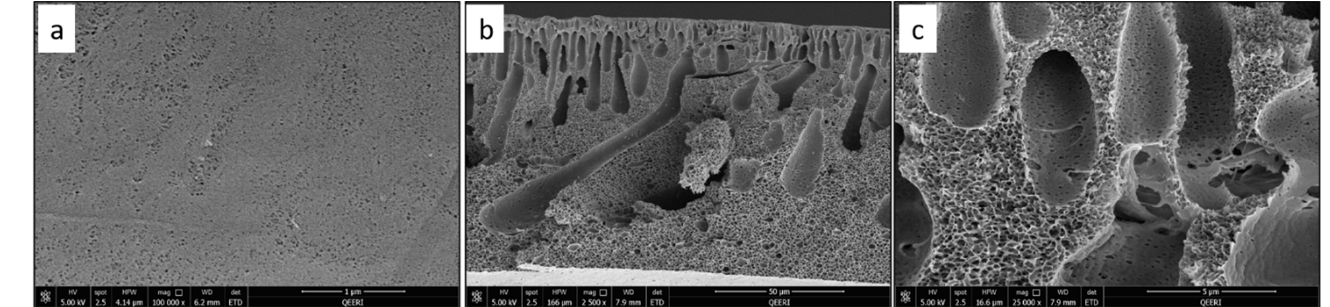
Figure 8. SEM images for PSF/0.5 wt.% CNF (M5) sample: ( a ) top surface, ( b ) cross-section, ( c ) enlarged top cross-section.